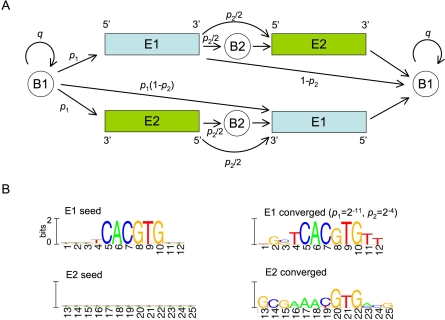
Probabilistic E1-E2 Model and Its Training(A) Structure of the circular E1-E2 hidden Markov model (HMM). All transition probabilities are indicated except when they are equal to 1, and q = 1 − 2p1 − p1(1 − p2). The background states B1 and B2 have tied emission states; for the E1 (13 positions) and E2 boxes (12 positions) the emissions in the reverse strand model (lower part) are tied with those in the forward direction.(B) The model is initialized with the matrices in the left and converges to the matrices on the right. Transition probabilities are those used throughout: p1 = 2−11, p2 = 2−4. All models are given at http://circaclock.epfl.ch/Models. Matrices are displayed in information format (Ia = max(0, palog2(pa/qa)), where pa are the probabilities for letter a in a column and qa are the (genomic) background frequencies.